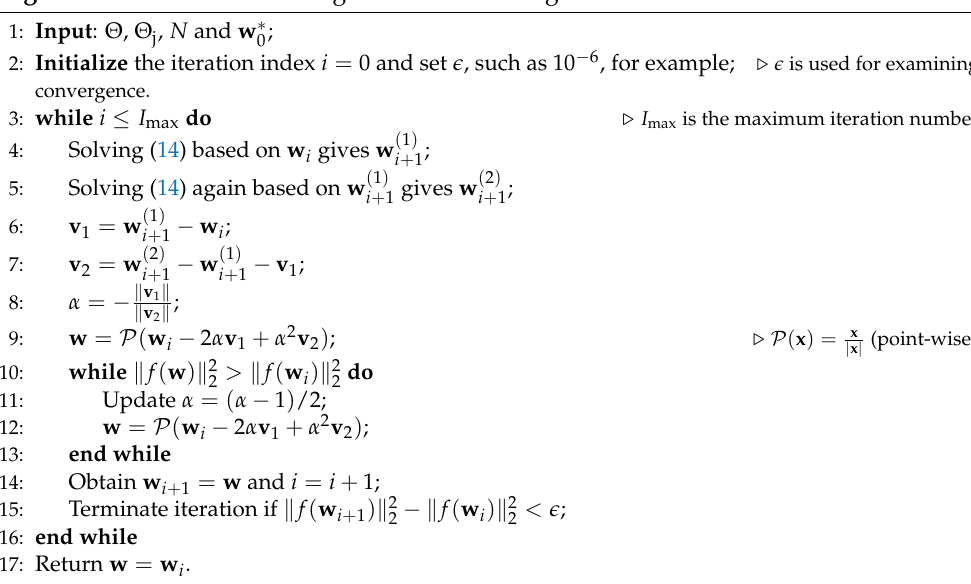
Algorithm 1 MM-based Analog Beamformer